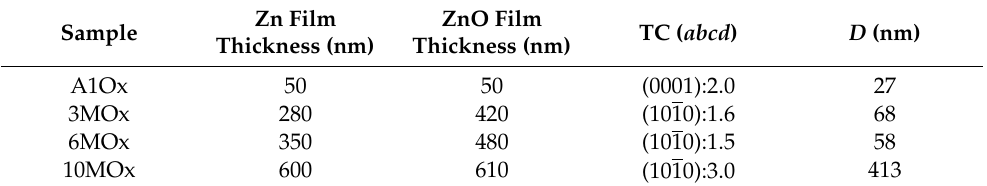
Table 1. Relevant structural and morphological parameters of the produced ZnO films in terms of the thickness of the precursor metallic Zn films. TC: Texture coefficient calculated by Equation (1). D : average grain size calculated by Equation